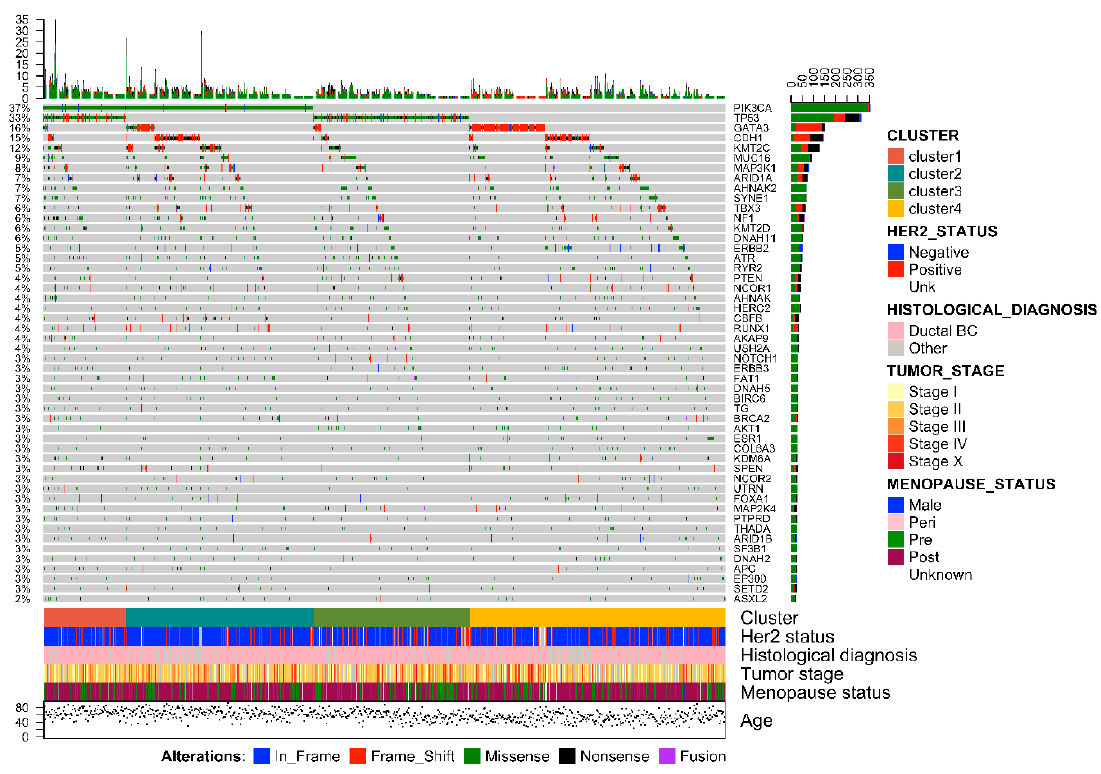
Figure 1. Oncoprint visualization of highly recurrent somatic molecular alterations in ER+/PR − breast cancers (959 samples). Each row represents a gene, as reported on the right, and was sorted by gene alterations frequency (bar plot on the right); types of alterations are color-coded on the basis of the legend on the bottom. Each column represents a sample and was sorted to appreciate the mutual exclusivity across genes. The bar plot on the top represents the number of samples showing alterations in the displayed genes. Cluster analysis, human epidermal growth factor receptor (HER)2 status, histological type, tumor stage, menopause status, and age at diagnosis are reported as rows at the bottom of the figure. Clustering was performed according to the mutual exclusivity and patterns of mutations.